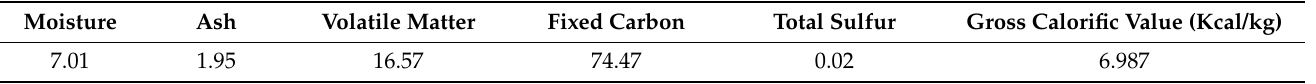
Table 2. Proximate analysis of coconut shell charcoal (in wt%) and its calorific value. Moisture